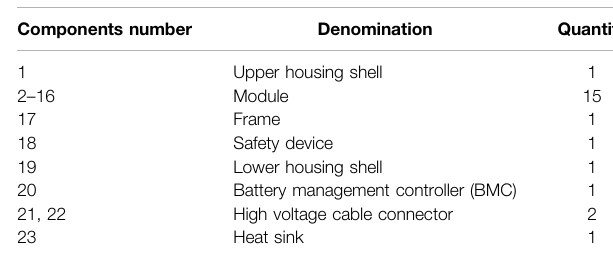
TABLE 1 | The components in the